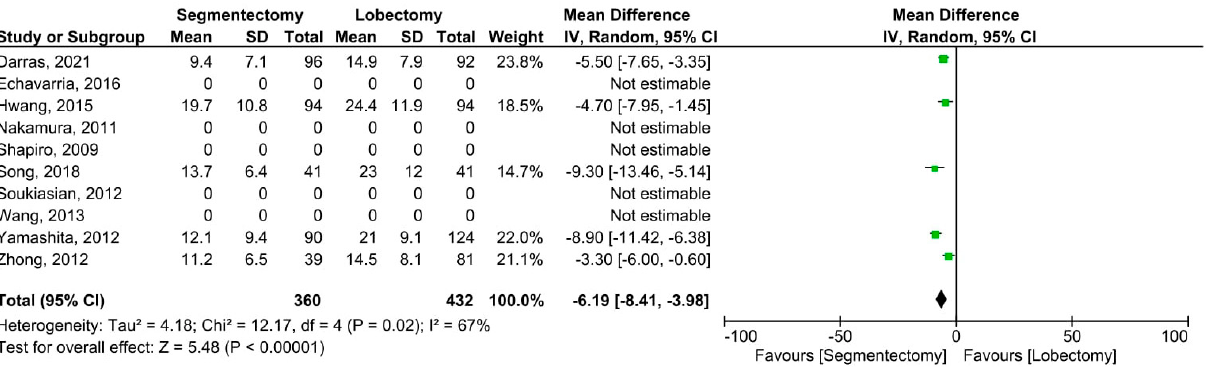
Figure 3. Forest plot for harvested lymph nodes of minimally invasive segmentectomy and lobectomy. CI = confidence interval; dF = degree of freedom; IV = inverse variance; SD = standard deviation [8,12–20].